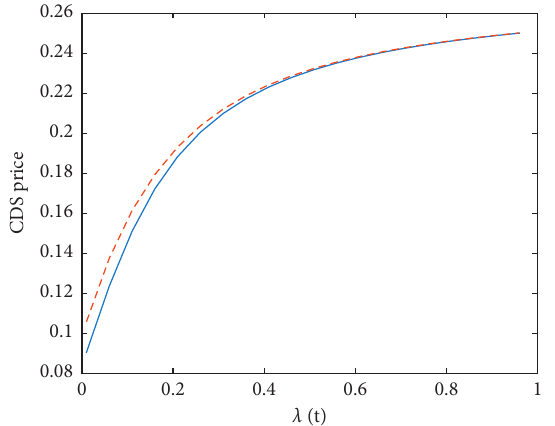
Figure 2: The CDS prices under different initial jump intensities.